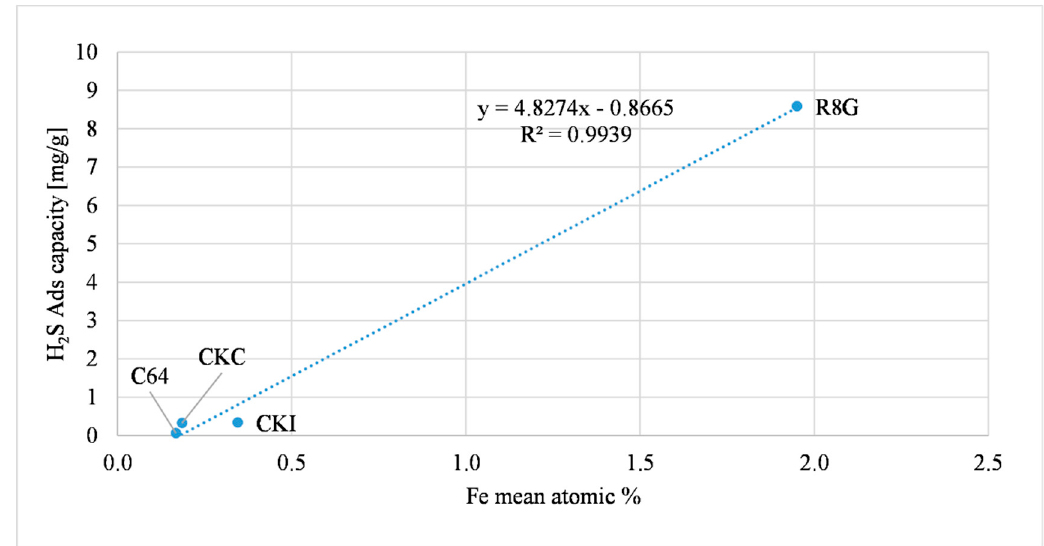
Figure 10. Iron effect on H 2 S adsorption (AC as received).